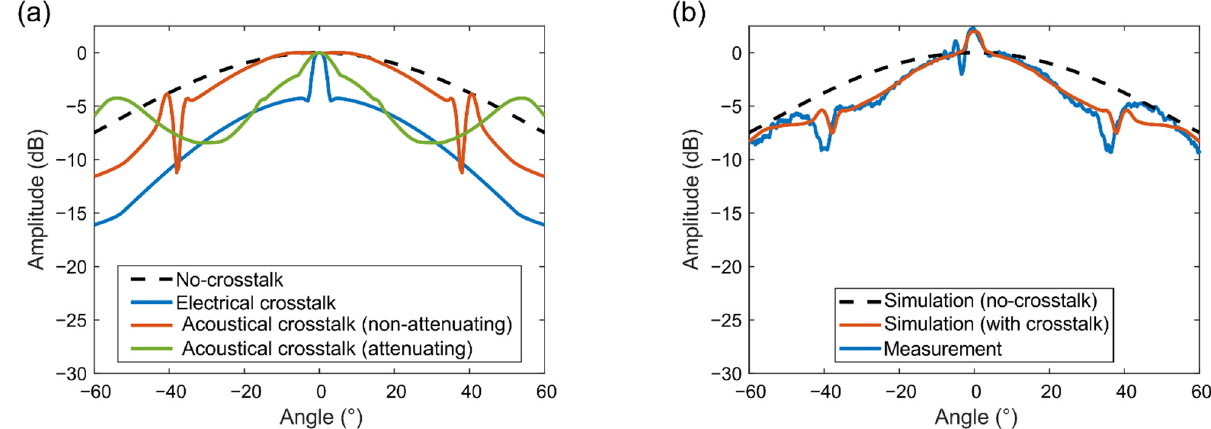
Figure A3. Directivity pattern along the x-direction. ( a ) Effect of individual crosstalks. ( b ) Effect of the combined crosstalk. Table A2. Parameters for crosstalk simulations.